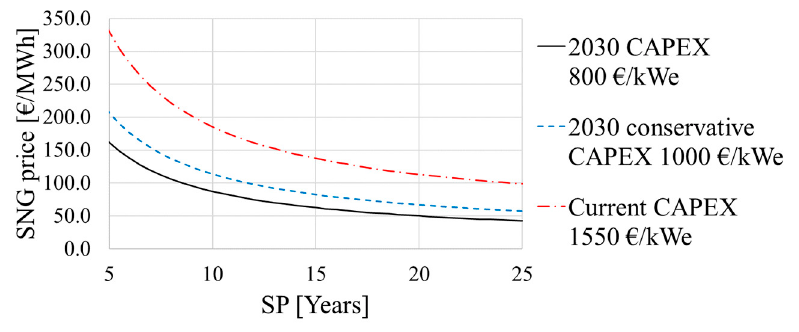
Figure 11. SNG price and Simple Payback period as a function of the P2G CAPEX.